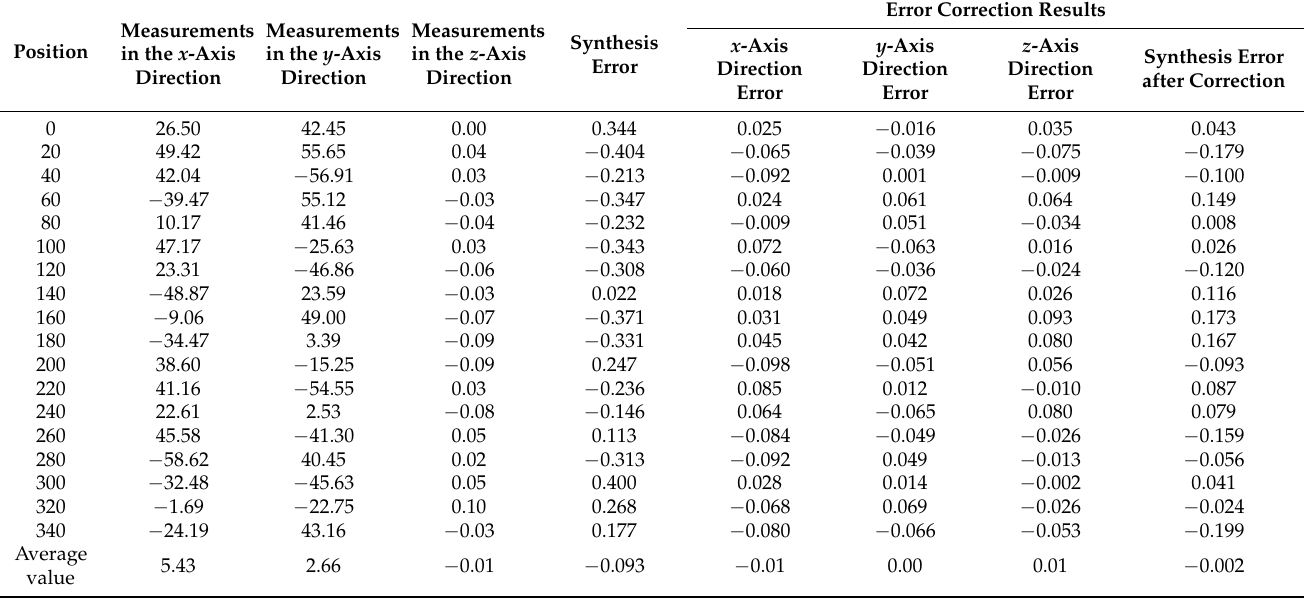
Table 4. Measurement and correction